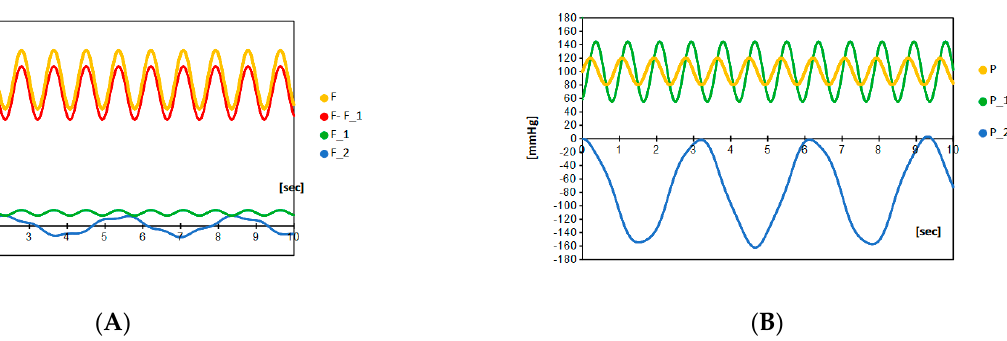
Figure 6. Blood flow ( A ) and blood pressure ( B ) at a given setting ( R = 2.2, C 1 = 0.100, C 2 = 0.100 and L 1 = 30, L 2 = 60). Although the amplitude of resonating pressure | P 2 | becomes large, the resonating flow F 2 is kept to be small enough to be less than 10 mL/min.